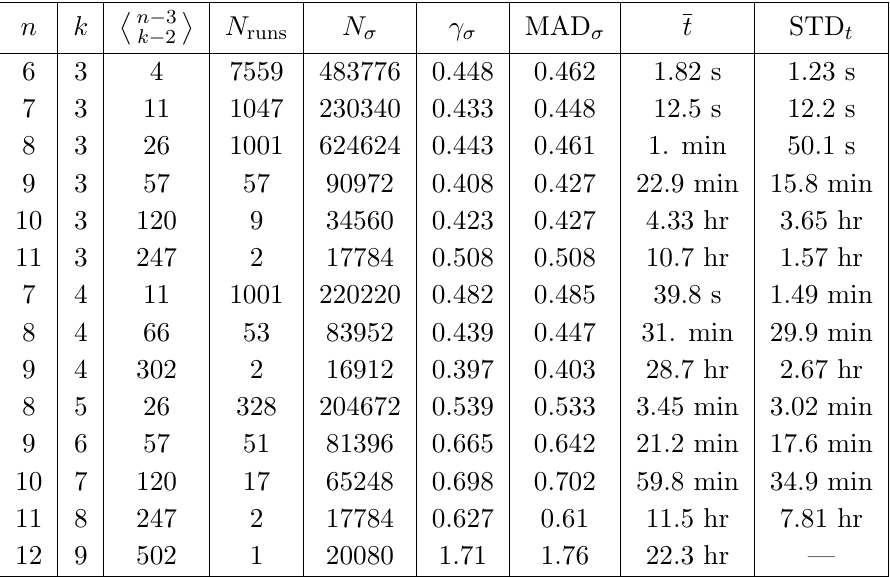
Table 2 . Statistical summary of distribution of solutions to 4D scattering equations and timings of NSolveMonteCarlo algorithm. N runs is the number of di(cid:11)erent set of numerical momenta used, D E n (cid:0) 3 N (cid:27) = (4 n (cid:0) 8) N runs is the number of solution points, (cid:13) (cid:27) is the scaling parameter of the k (cid:0) 2 (cid:12)tted Cauchy distribution and MAD (cid:27) is the median absolute deviation. t is the average time and STD t is the standard deviation. Note that when N runs is small solution point statistics may not be reliable even though N (cid:27) is large, as they come from a small number of di(cid:11)erent choices of numerical